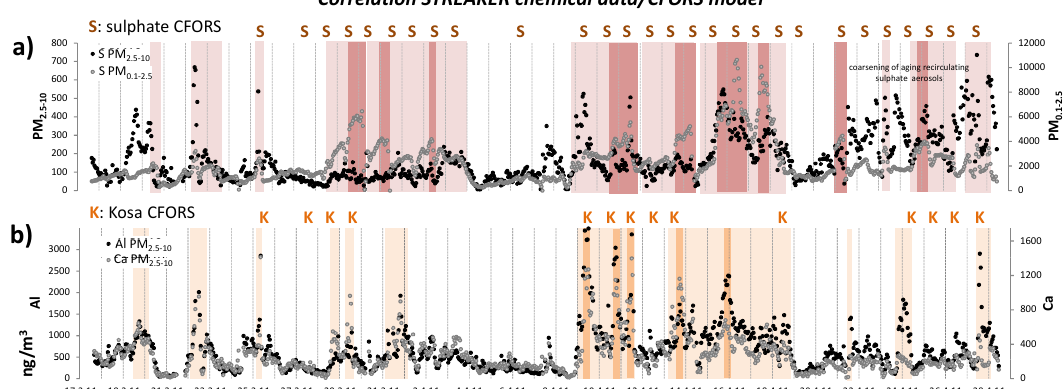
Fig. 5. Hourly Streaker data for sulphatic peaks (a) and mineral dust peaks (b) . Days when sulphatic (S) and dust (K) events were predicted by the Chemical Weather Forecasting System